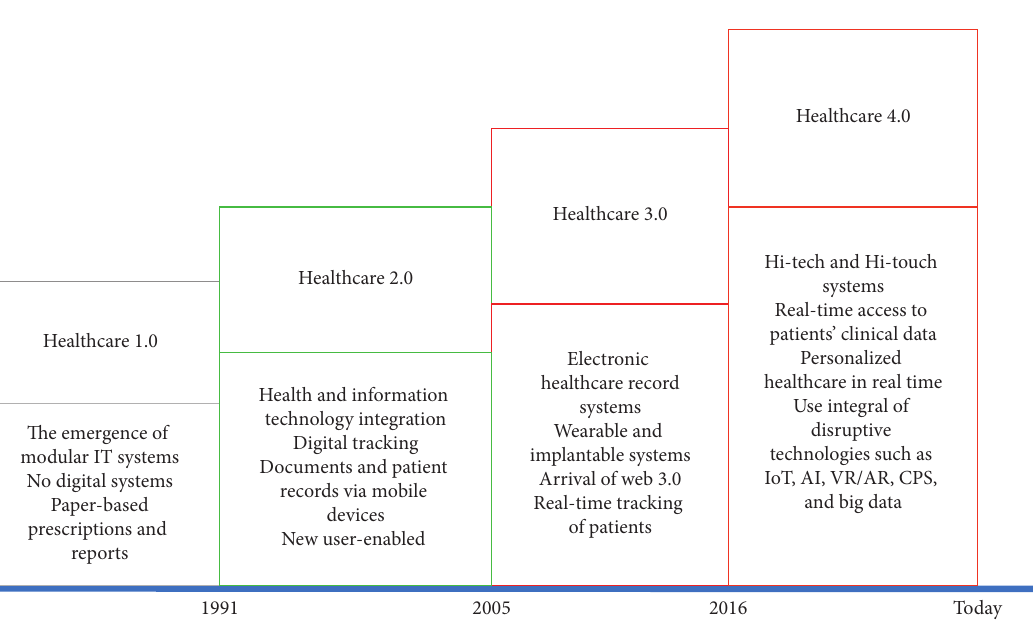
Figure 7: Evolution of the healthcare